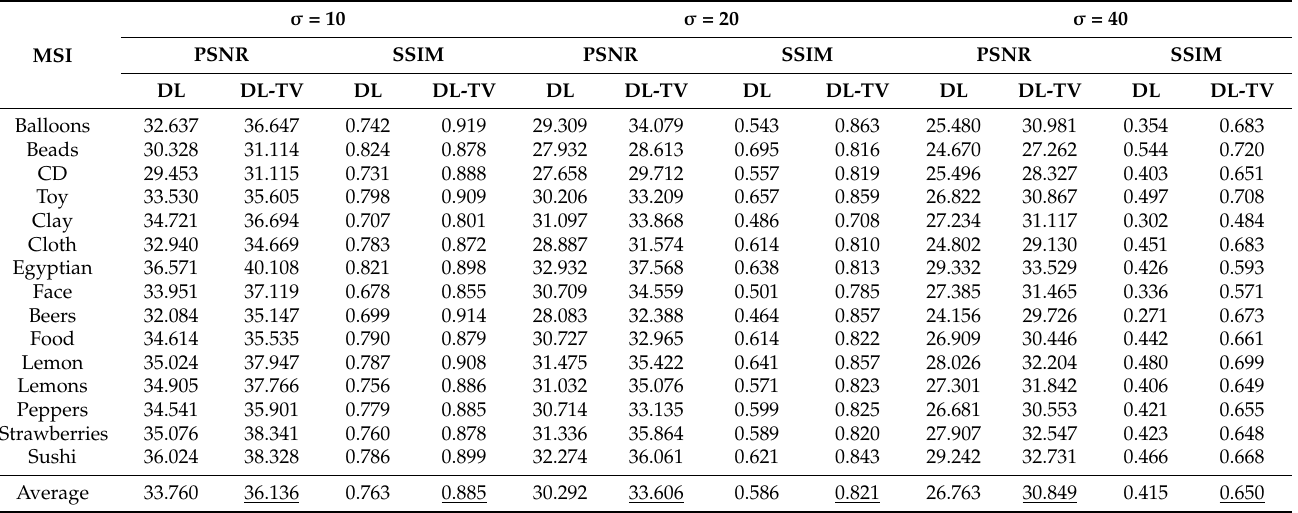
Table 5. Average PSNR and SSIM of 15 reconstructed MSIs under different levels of noise, obtained using the CAVE dataset.